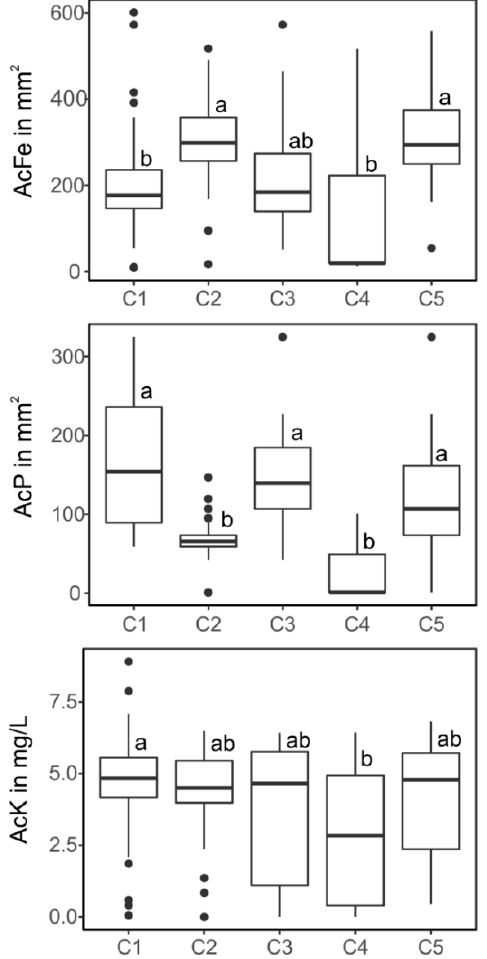
Figure 4. Activities for phosphate and potassium solubilization, as well as siderophore production